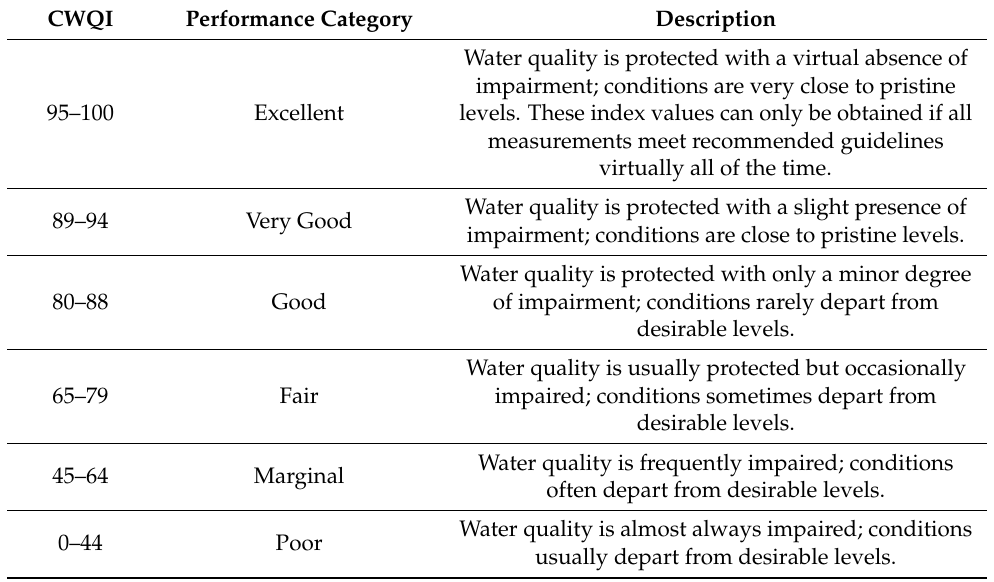
Table 4. Categorization of the CCME-WQI as defined by CCME [16].